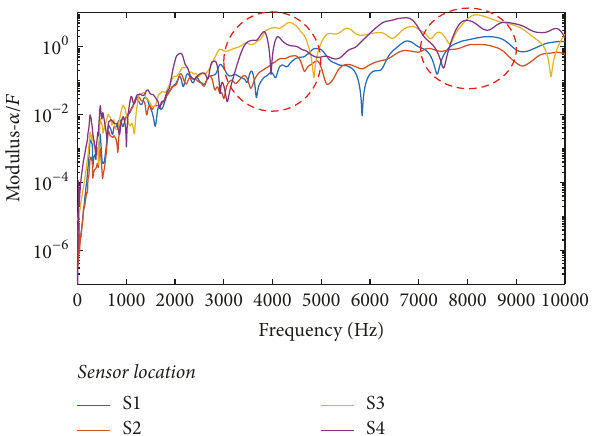
Figure 18: Simulated FRFs obtained in four different sensor loca- tions exciting from B2.